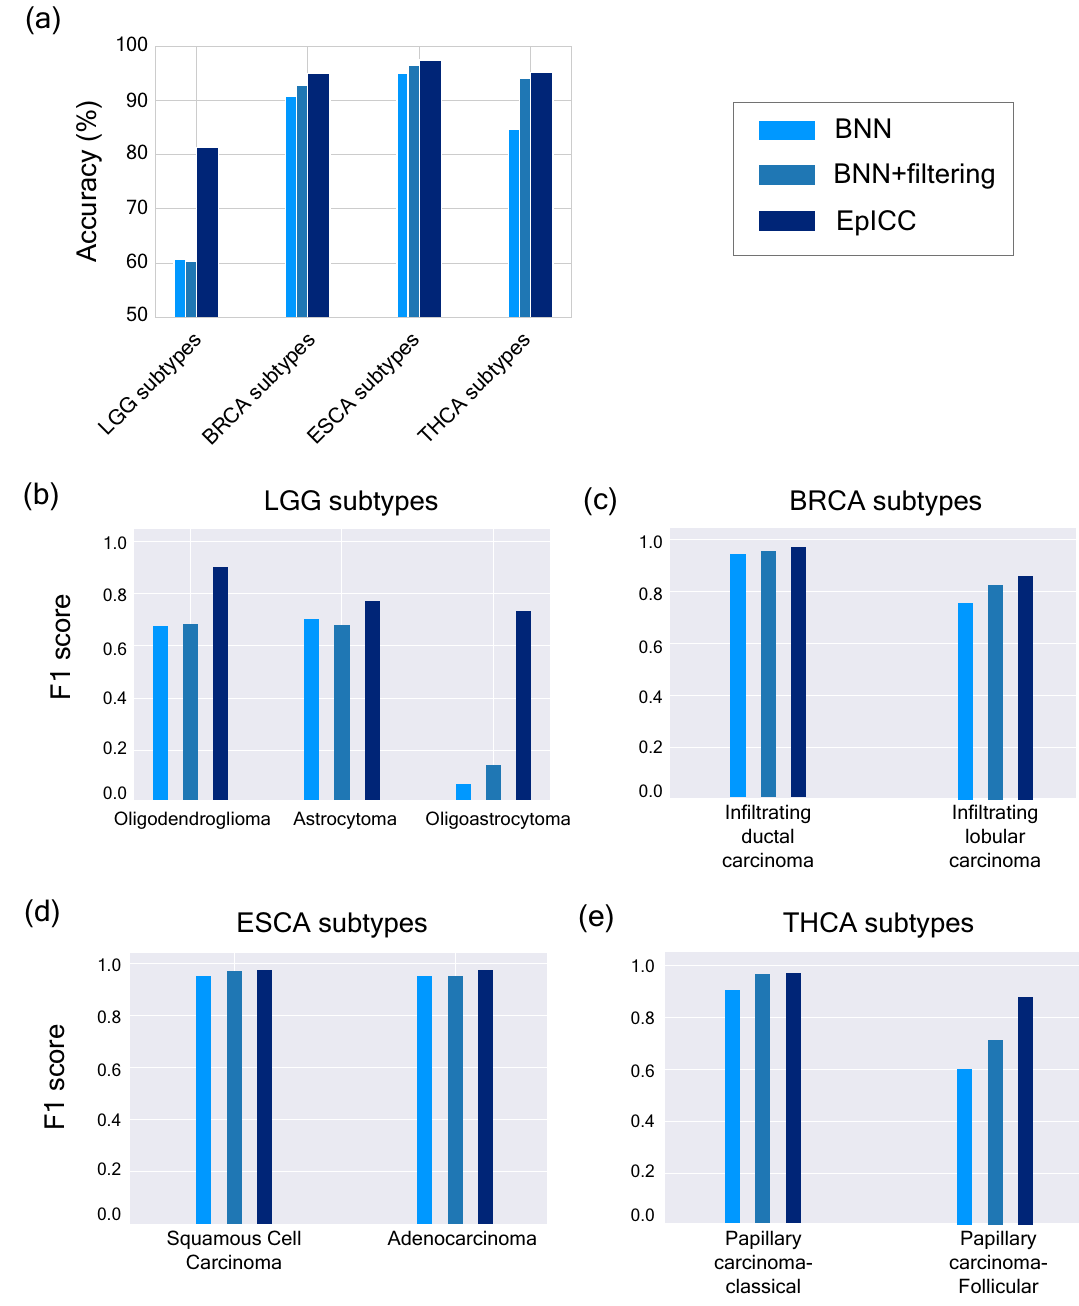
Figure 4. EpICC accurately predicts cancer subtypes. ( a ) Comparison of classification accuracy of BNN alone, BNN with uncertainty filtering and EpICC for cancer subtype classification. Comparison of F1 scores of the prediction made by BNN, after filtering based on mean training uncertainties of correct predictions and after applying uncertainty correction (EpICC) for ( b ) LGG subtypes ( c ) BRCA subtypes ( d ) ESCA subtypes ( e ) THCA